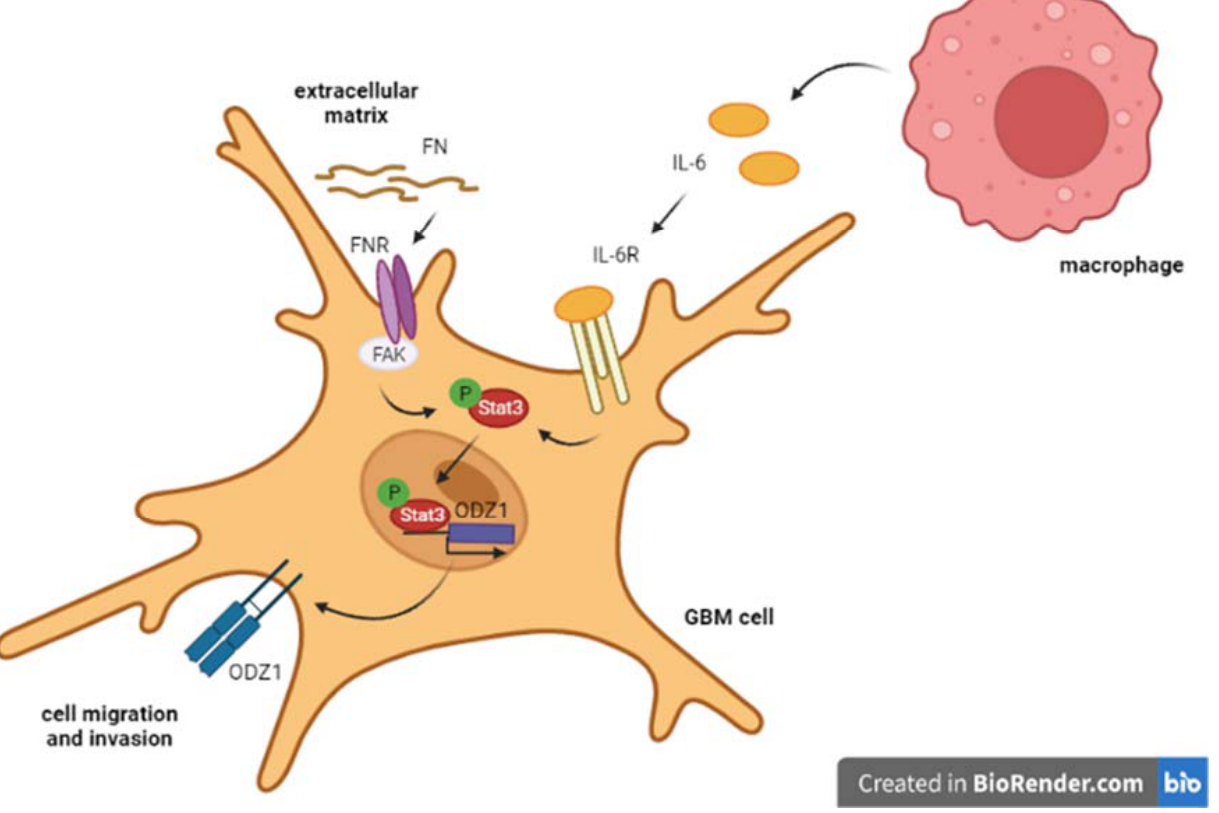
Figure 1. Schematic representation of the Stat3-dependent ODZ1 expression. IL-6 from activated macrophages and fibronectin of the ECM activated Stat3, promoting its phosphorylation. Activated Stat3 binds to the ODZ1 promoter and induces its expression [15].